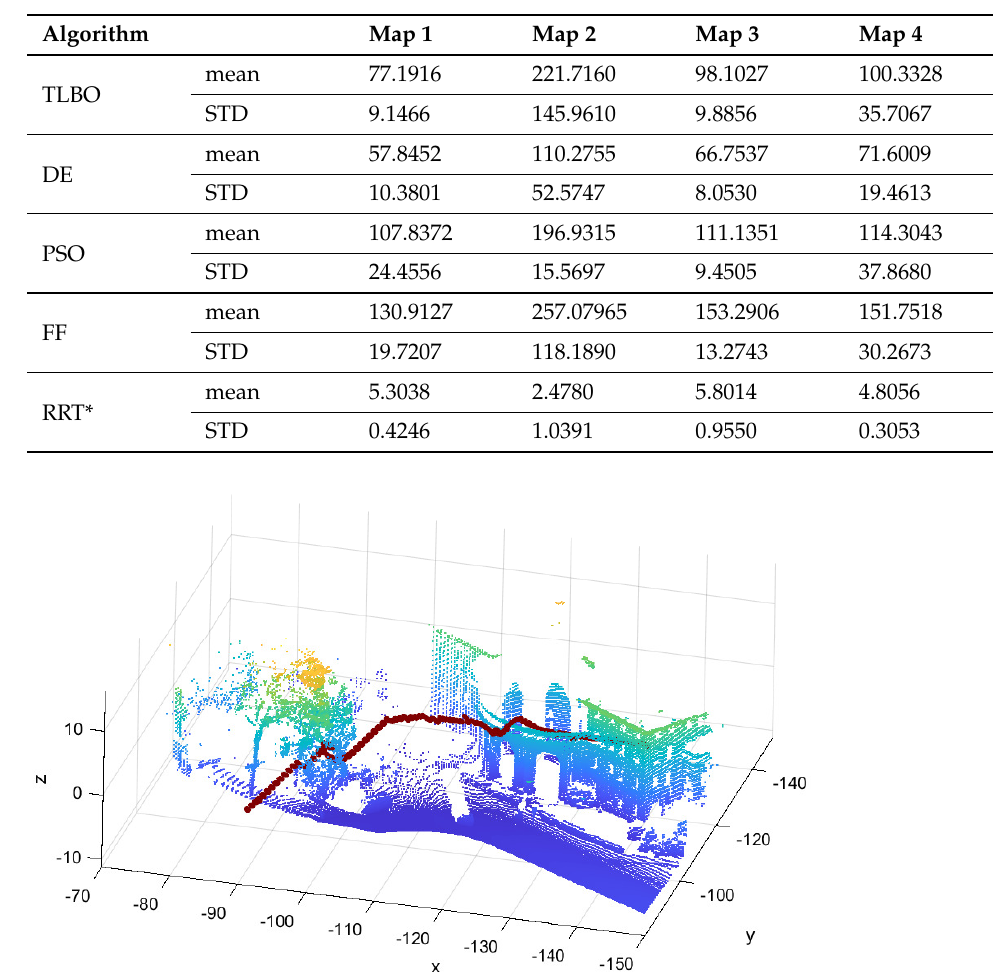
Table 5. Experimental results, mean and standard deviation of the run-time of each algorithm in seconds.